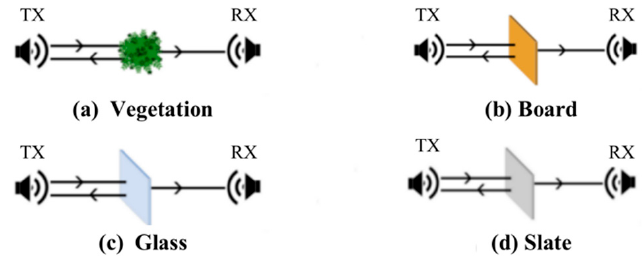
Figure 6. Schematic diagrams of the relative position of the occluders and the transceiver in the experiment.